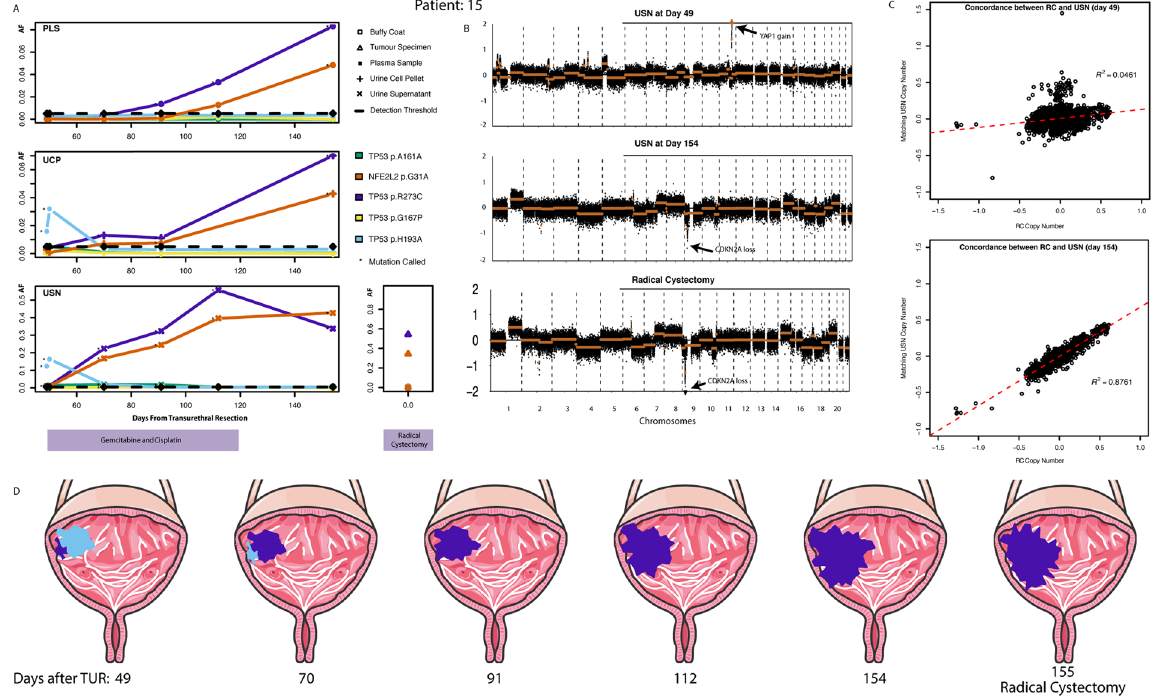
Figure 5. mutDNA demonstrates on-therapy tumour evolution. ( A ) SNV plots for patient 15 demonstrate tumour evolution. SNV analysis of pre-NAC urinary samples revealed a de novo TP53 H193A mutation (light blue), whilst TP53 R273C (purple) and NFE2L2 G31A (orange) SNVs were only observed at low AFs in USN samples (1% and 1.1% respectively). During NAC, the clone containing TP53 R273C and NFE2L2 G31A SNVs appears to grow considerably, whilst the TP53 H193A SNV containing clone recedes to become undetectable at later time-points. This profile was mirrored by the cystectomy sample. ( B ) CNA profiles demonstrate tumour evolution. Marked CNA changes were observed in urine sample at pre-NAC (including YAP1 focal amplification). This CNA profile differed from that seen in later time-points. At time-point 6, the CNA profile resembles one seen at cystectomy. ( C ) Concordance of cystectomy and USN CNA profiles during NAC. We generated a linear model by fitting autosomal 1 Mb bin read-counts in the cystectomy sample against those in peripheral samples. Initial USN CNA profiles are discordant with the cystectomy sample (R 2 = 0.0461). Subsequently a concordant CNA profile emerges (R 2 = 0.8760), mirroring the SNV results. D. Longitudinal mutDNA analysis suggests on-therapy tumour evolution. We used the changing SNV and CNA profiles to suggest a clonal evolution paradigm in patient 15. (Images adapted from Servier Medical